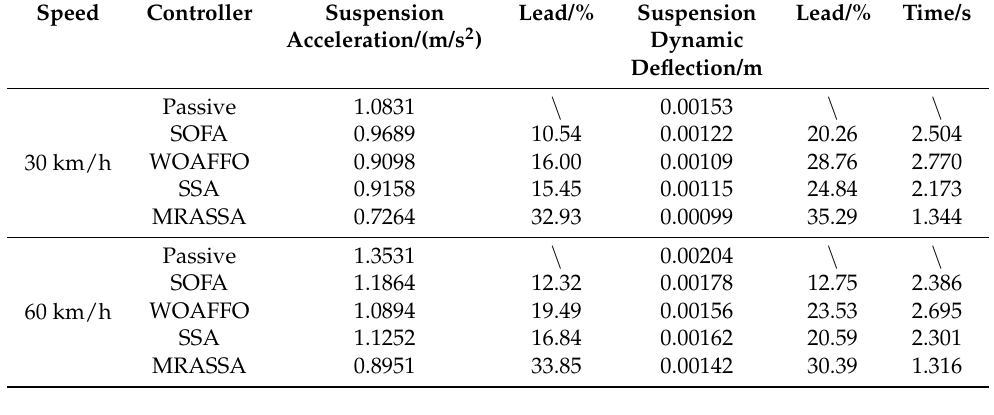
Table 6. Optimization Results for Platform of the Random Road.